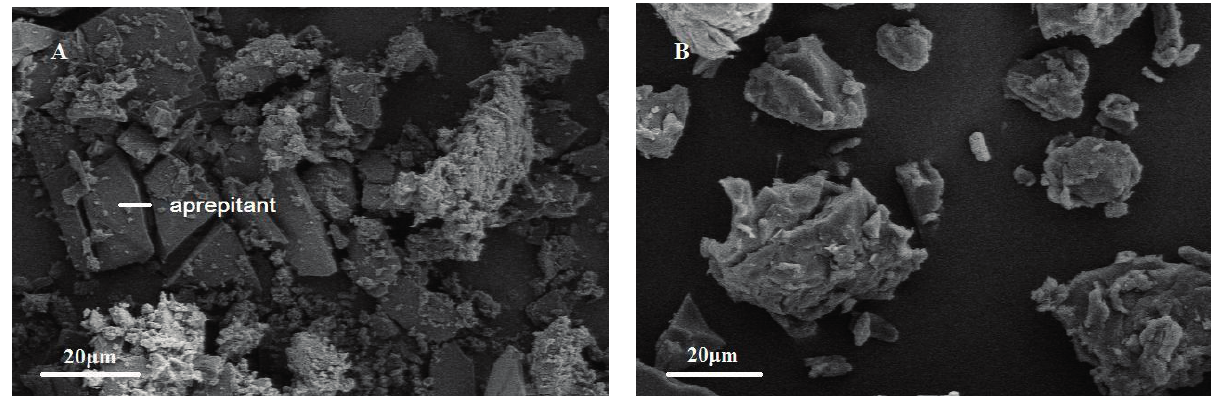
Figure 4. Scanning electron microscopy (SEM) photomicrographs of PMs ( A ) and SDs ( B